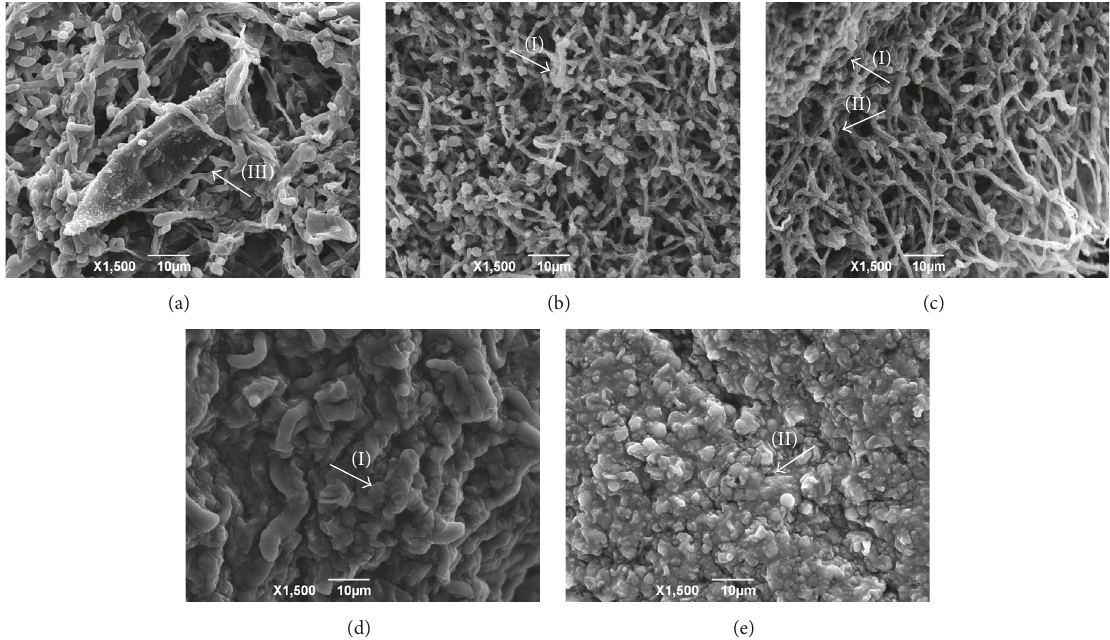
Figure 2: Electron micrographs of M. canis ATCC 32903 exposed or not to the reference drugs and hexahydropyrimidine derivative of interest. (a) M. canis ATCC 32903 not subjected to pharmacological treatment; (b) fungus M. canis ATCC 32903 subjected to treatment with terbinafine; (c) M. canis ATCC 32903 subjected to treatment with ketoconazole; (d) M. canis ATCC 32903 subjected to treatment with HHP3; (e) M. canis ATCC 32903 subjected to treatment with HHP4. Arrows indicate the appearance of wrinkled (I) and crushed (II) hyphae and the presence of macroconidium